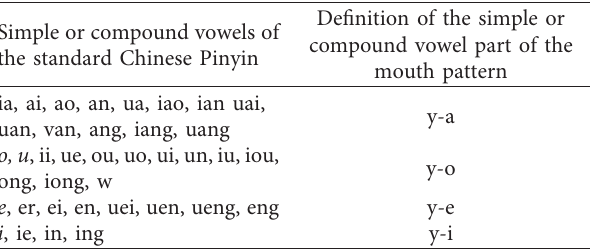
Table 2: Conversion table for the simple or compound vowels of the standard Chinese Pinyin.